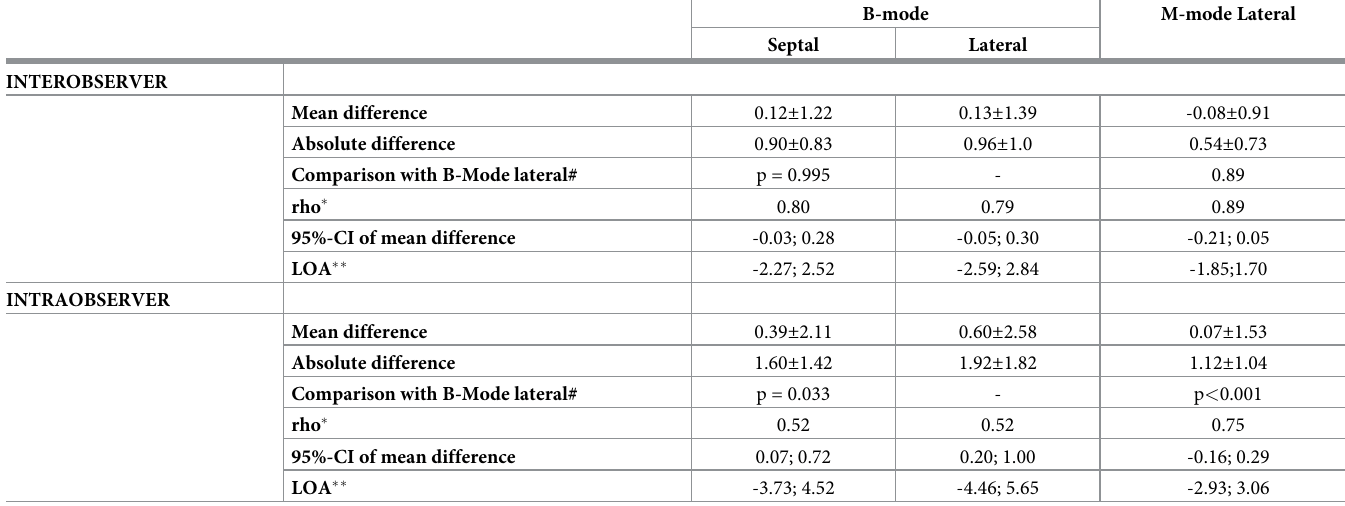
Table 2. Inter- and intraobserver reproducibility of b-mode and m-mode derived MAPSE measurements.